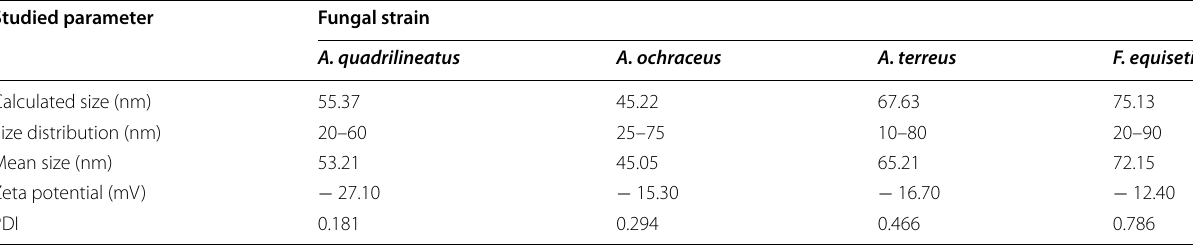
Particle size was calculated from the Scherrer equation. Mean size, size distribution, zeta potential and PDI were obtained from the DLS analysis as described in Materials and Methods